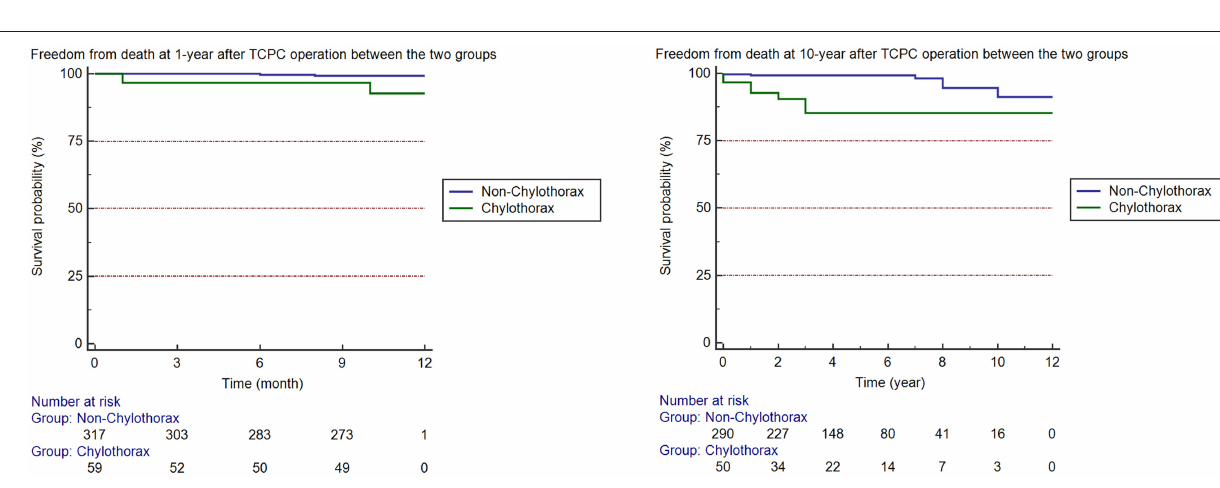
FIGURE 2 | Early-term complications after TCPC operation between patients with and without chylothorax. * p < 0.05 between the two groups.